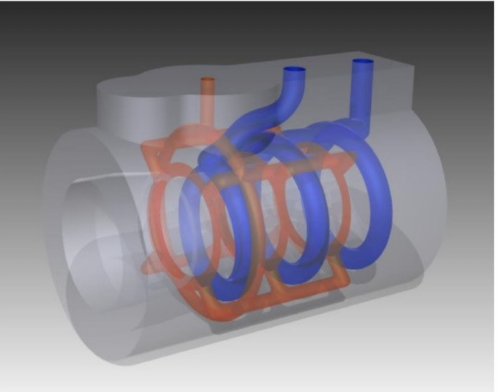
Figure 19. The calibration tool: The internal cooling and vacuum channels were integrated in a very compact design space. The minimum distance between the channels is about 1 mm [114].